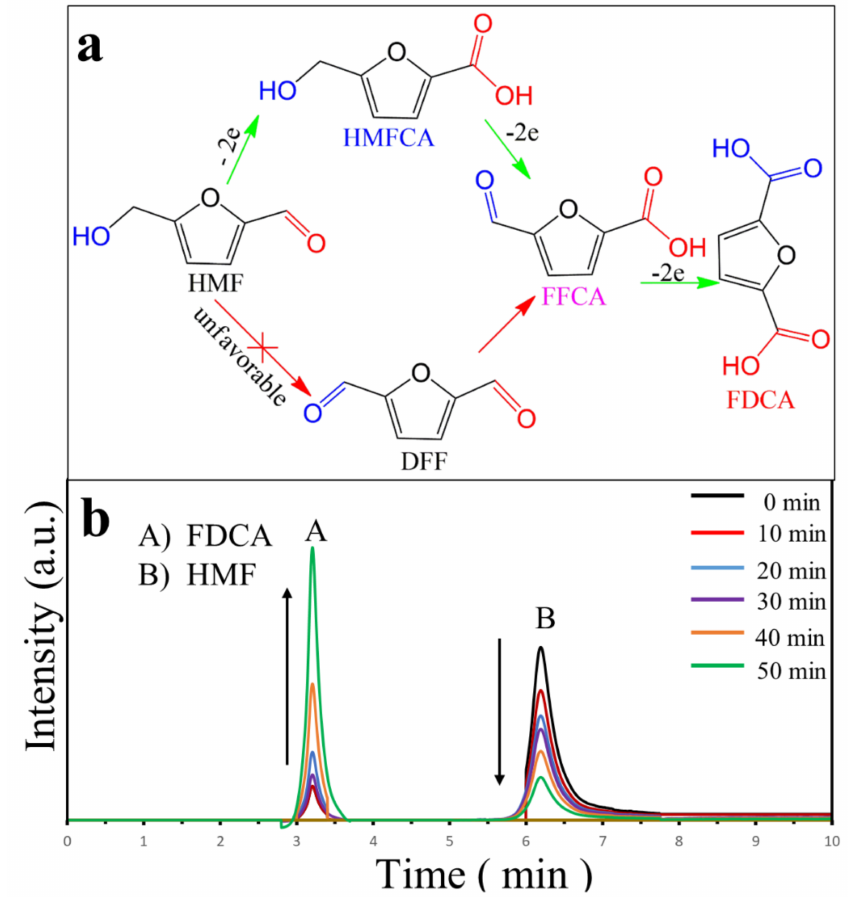
Figure 4. ( a ) HMF electrochemical oxidation reaction pathways. The first pathway starts with the oxidation of the aldehyde group to form HMFCA. The second pathway starts with the oxidation of the alcohol group of HMF to give DFF over CoB/g-C 3 N 4 @NiF. ( b ) HMF concentration change and the oxidation product over electrolysis